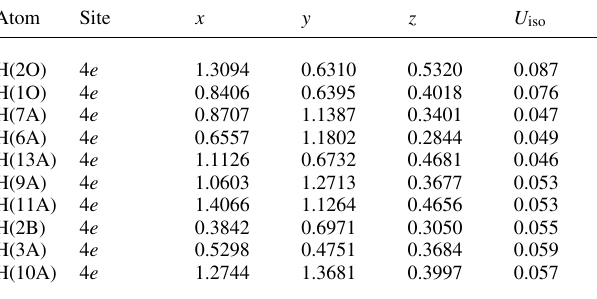
Table 2. Atomic coordinates and displacement parameters (in Å 2 ) .